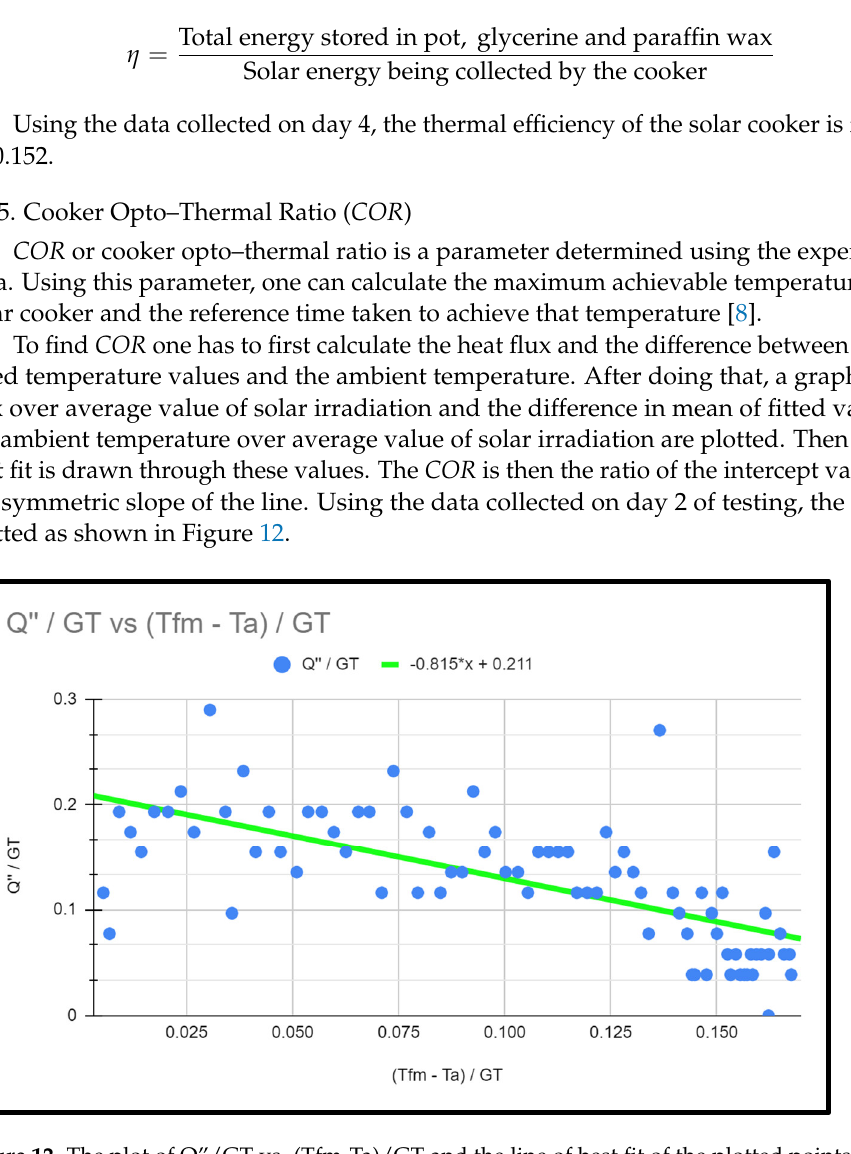
Figure 12. The plot of Q″/GT vs. (Tfm-Ta)/GT and the line of best fit of the plotted points.